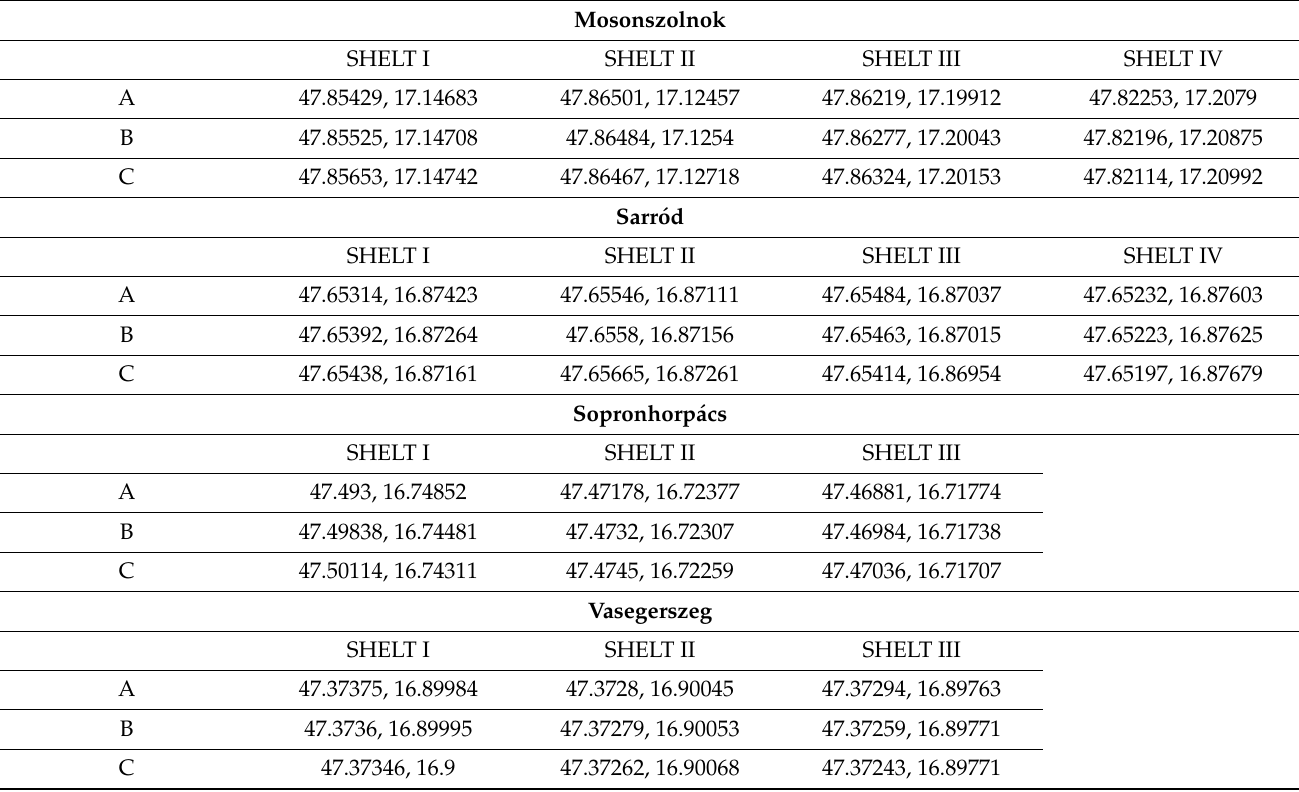
Table A1. GPS coordinates of the